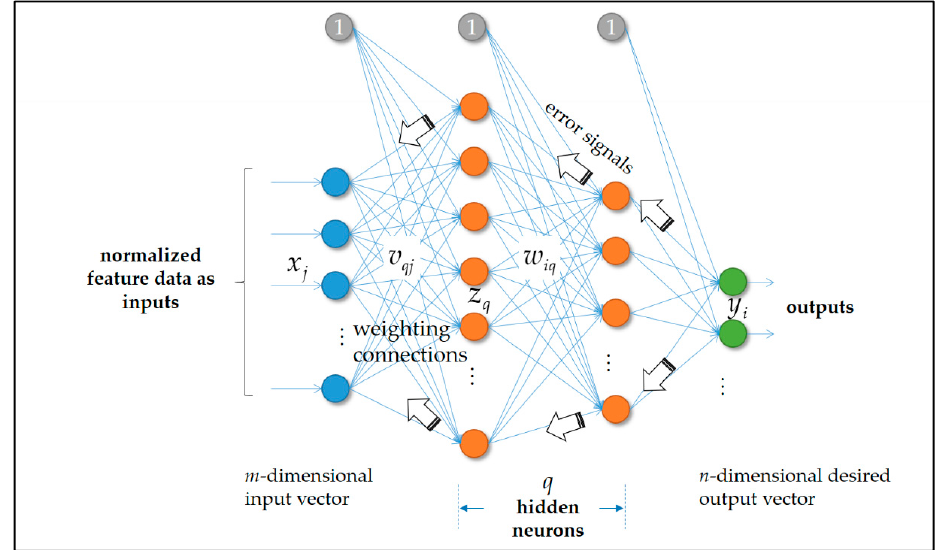
Figure 6. Structure of a feed-forward backpropagation (BP) artificial neural network (ANN) model used in this work, trained by a gradient-descent (GD) learning process in cloud analytics and compared, as a comparative study, with a fuzzy C-means (FCM) clustering/piloting radial basis function (RBF) ANN model.